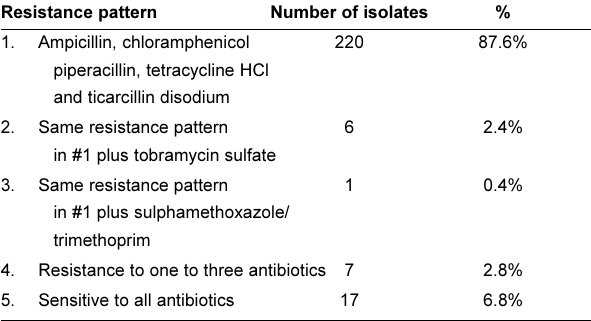
Figure 4) Geographical distribution of rates of Salmonella serotype typhimurium (S typhimurium) reported in Ontario from 1990 to 1997